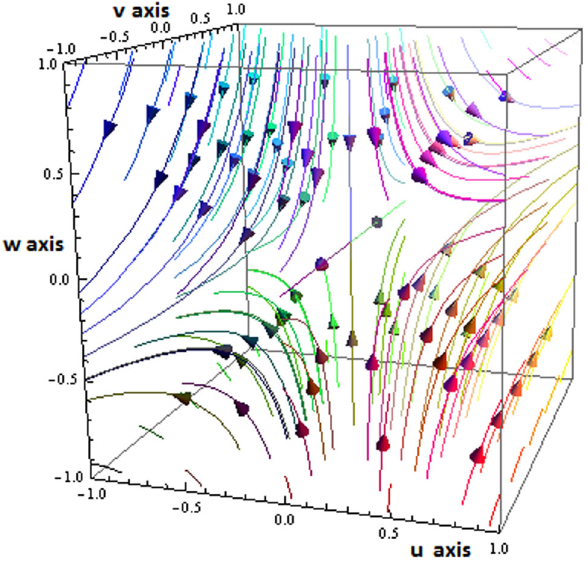
Fig. 4 3 dimensional phase plot for the critical point P